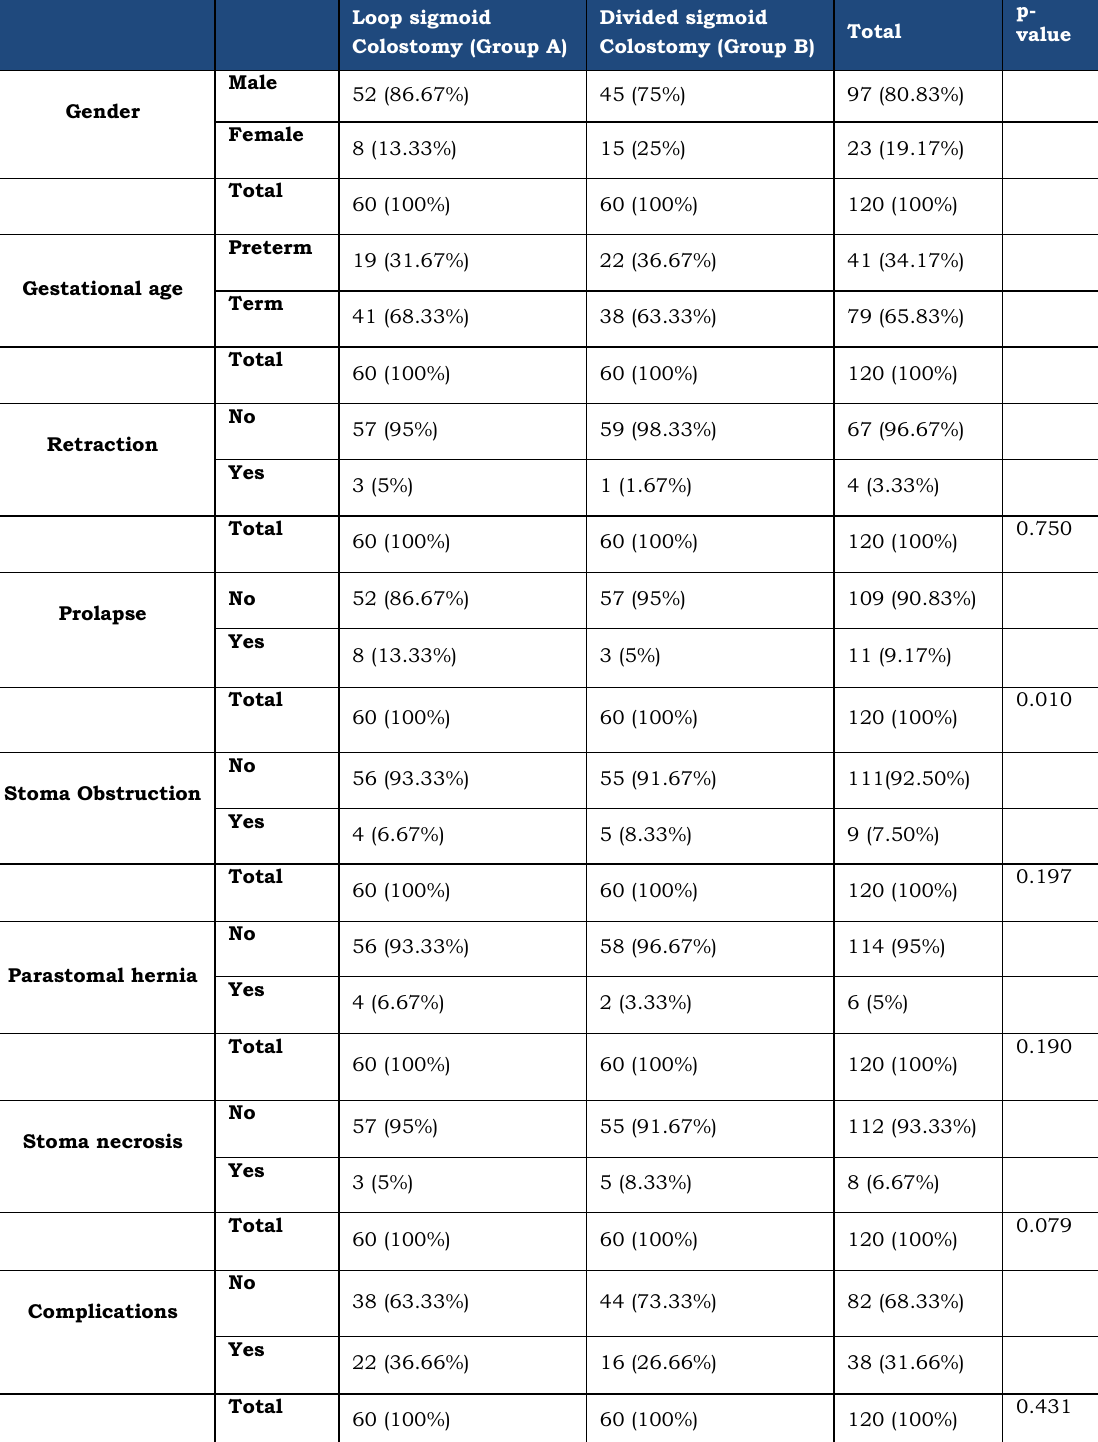
Table 1: Comparison of both